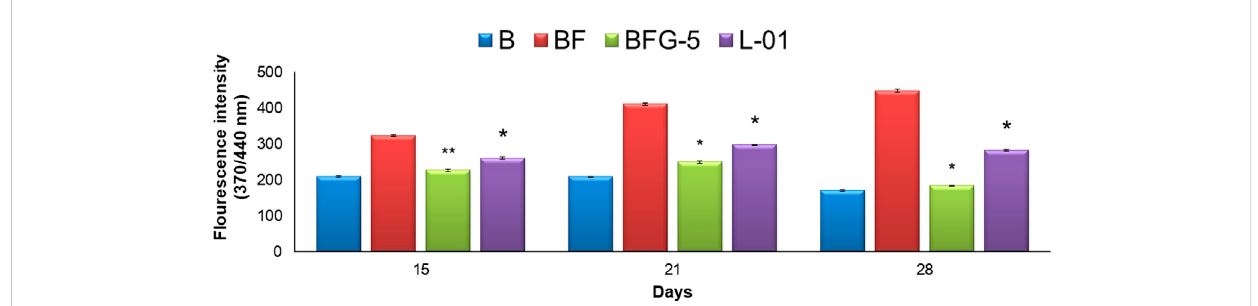
FIGURE 5 Effect of L-01 on the formation of fl uorescent AGEs in BSA incubated with fructose. p * < 0.01, p ** < 0.05, p *** < 0.001 relative to control i.e., compared to BSA/Fructose (BF) on same duration. (B: BSA, BF: BSA/fructose, BFG-5: AG in BSA/fructose at 5 mM, L-01 in BSA at 100 μ g/mL).